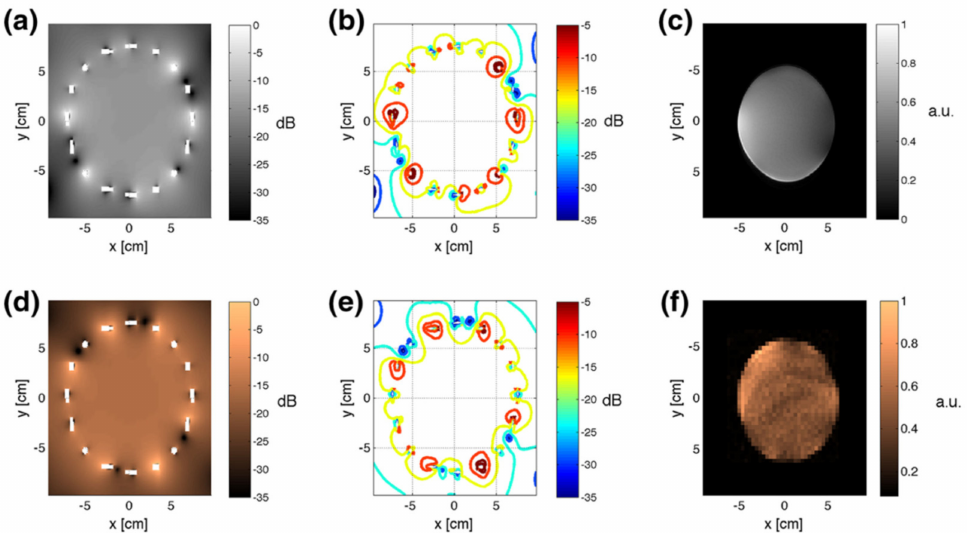
Figure 9. ( a ) Simulated and measured field maps in the central axial plane: Simulated field map; ( b ) corresponding contour plot; ( c ) measured field map at hydrogen frequency; ( d ) simulated field map; ( e ) corresponding contour plot; ( f ) measured field map at sodium frequency. Reprinted by permission from Giovannetti et al., App Magn Reson 2015